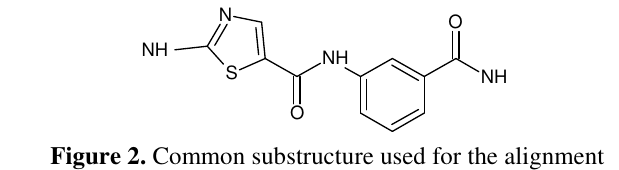
Figure 2. Common substructure used for the alignment